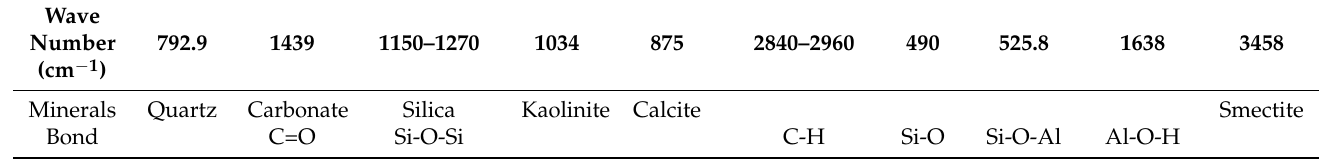
Table 6. Minerals and their wave number observed in the FTIR